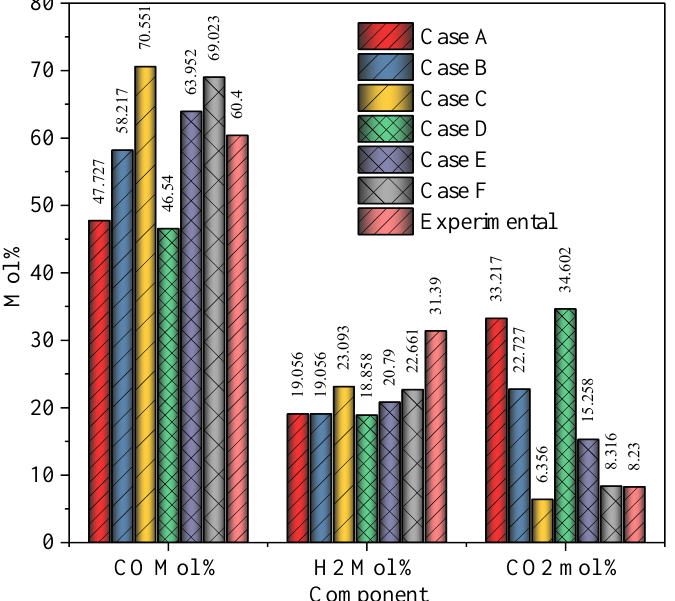
Figure 5. The evaluation of various preliminary reaction results for H 2 , CO2, and CO mol percentages in coal at O/C = 1.